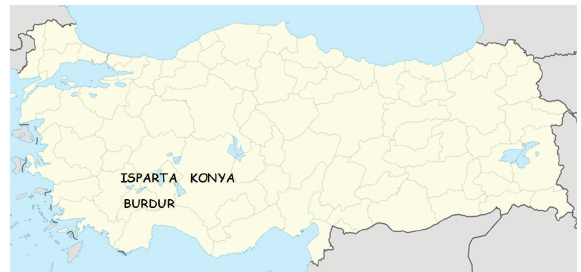
Figure 1: Sampling the provinces.